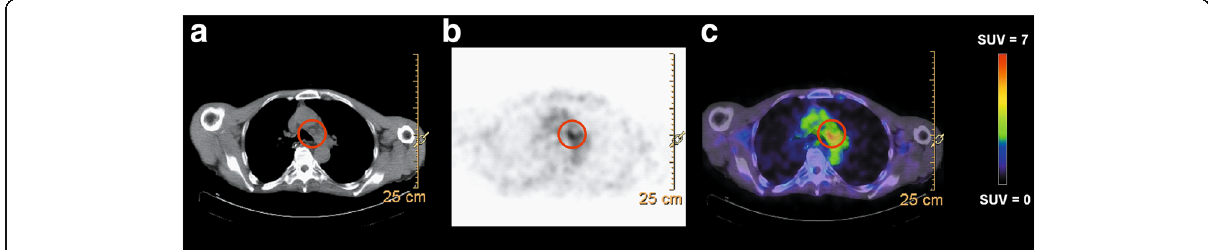
Fig. 5 Example of tumour uptake of 89 Zr-RG7356 at 96 h p.i.. Tumour lesion mediastinal/in the aorta – pulmonary window (patient 8, 450 mg cohort). a Low dose CT. b Attenuation-corrected PET. c Fused